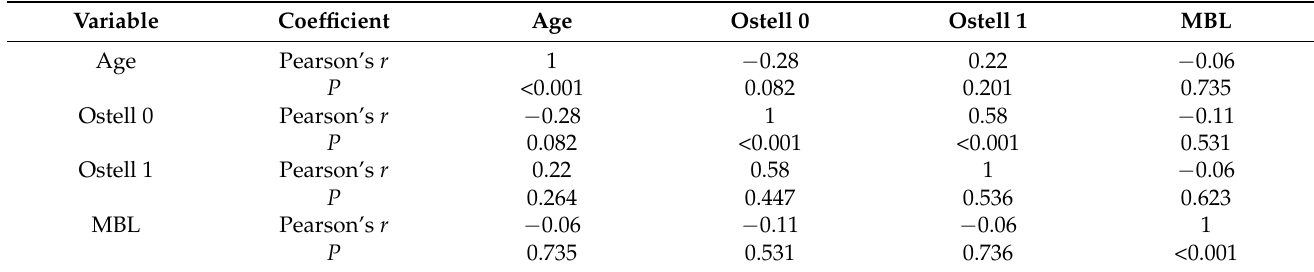
Table 2. Linear correlation coefficient for groups one and two and their significance for the selected continuous variables.